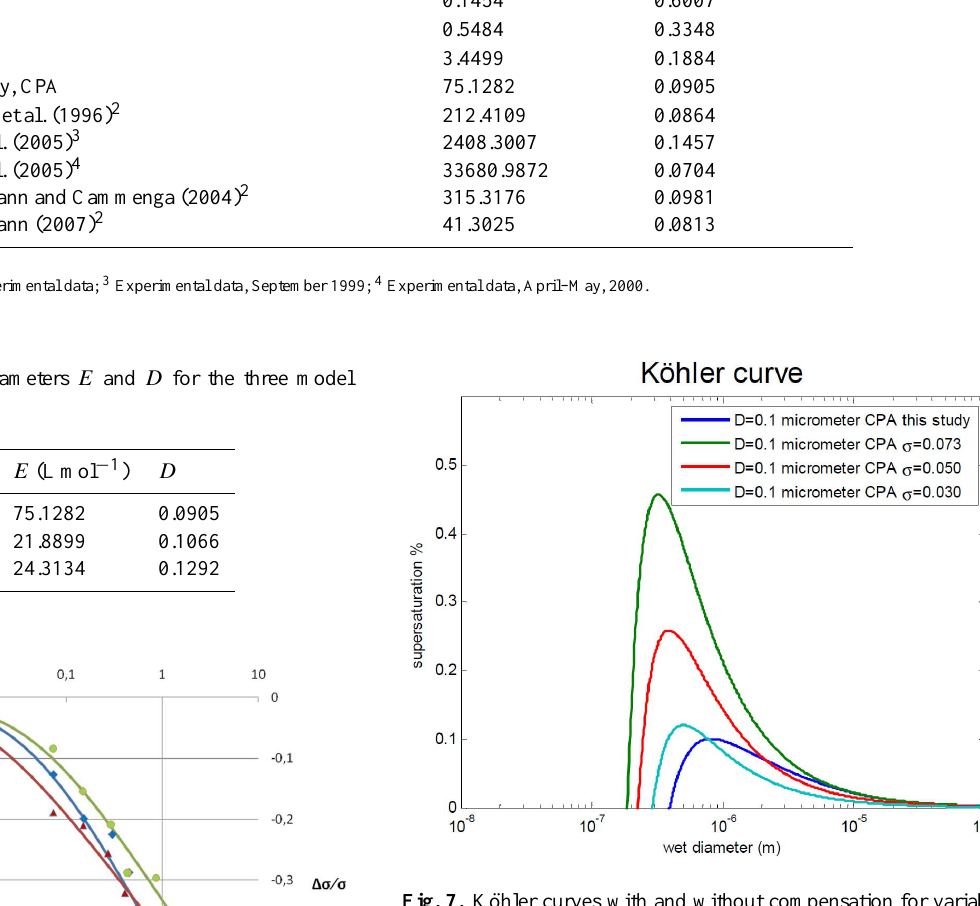
Fig. 7. K¨ohler curves with and without compensation for variable values for surface tension, determined by the Szyszkowski equation, using values for parameters D and E from this study. Dry diameters are in the four curves